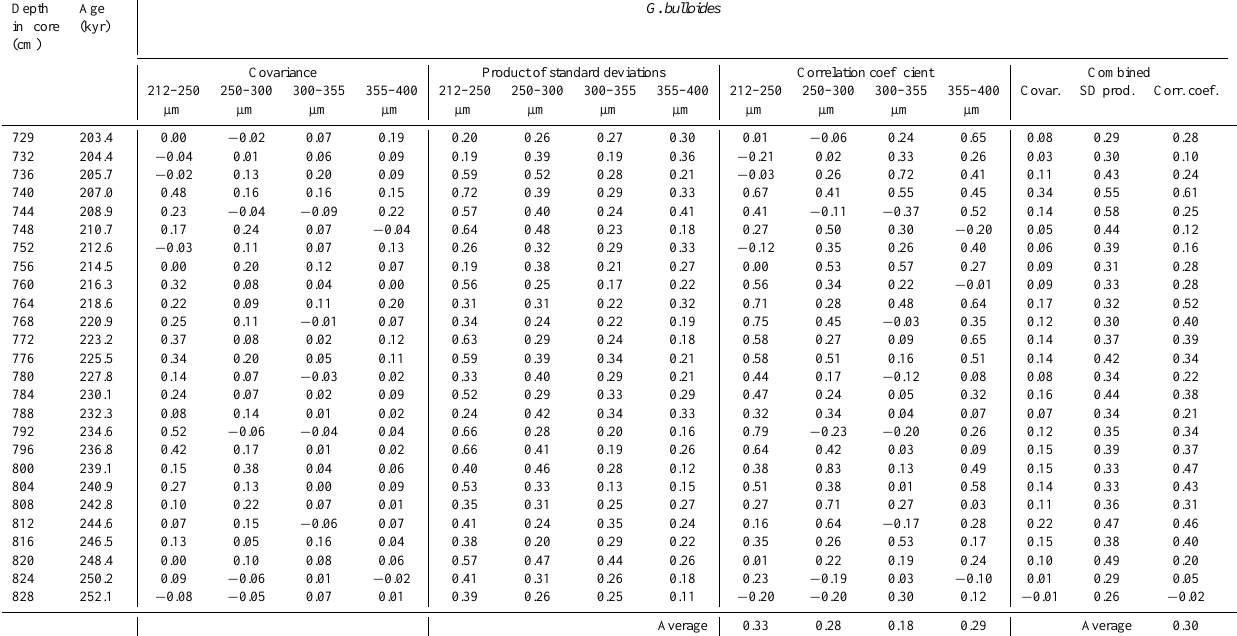
Table 4. Covariance of studied planktonic foraminifera. Test values for covariance and correlation coefficient of G. bulloides. Depth Age (kyr) in core (cm)